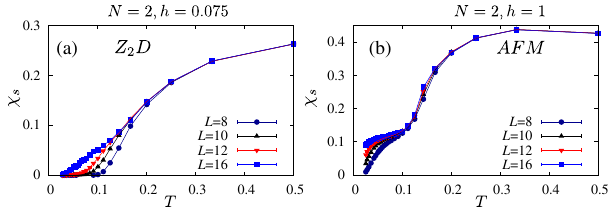
FIG. 13. Uniform spin susceptibility at (a) h ¼ 0 . 075 (Z 2 D phase) and (b) h ¼ 1 (AFM